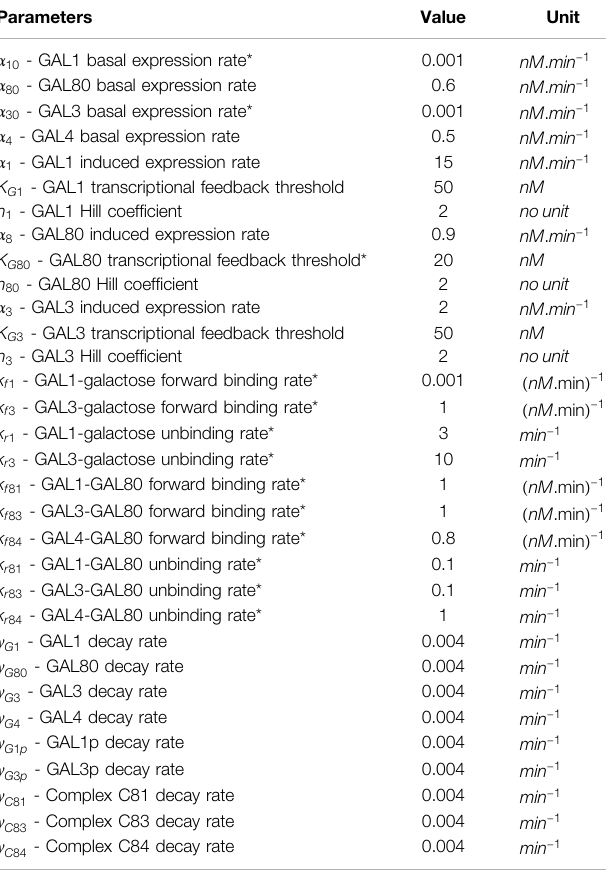
TABLE 1 | Parameters value used in both deterministic and stochastic model to simulate GAL network. Parameter values taken from (Venturelli et al., 2012), unless otherwise noted with a * in column